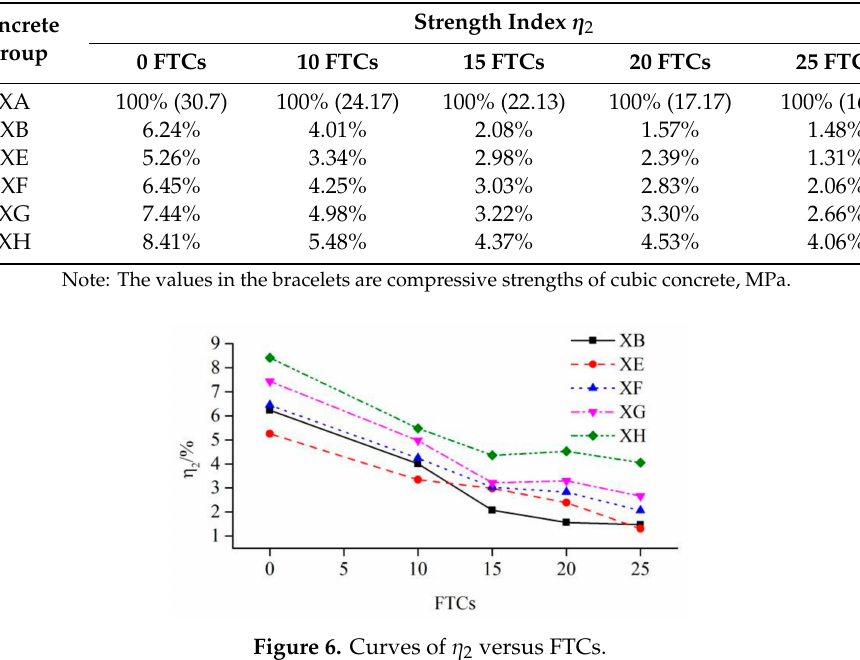
Table 4. The values of η 2 .